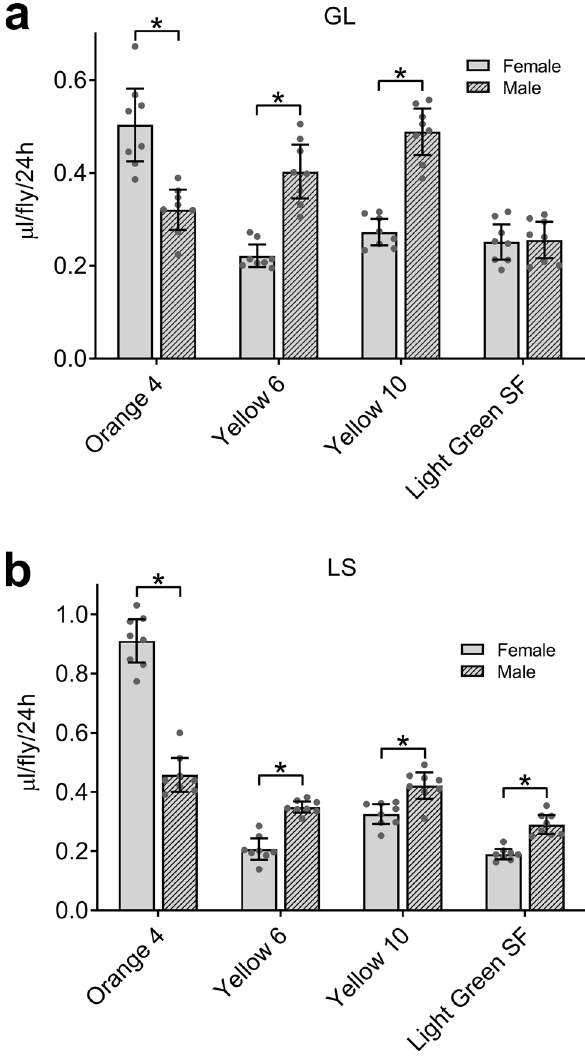
Figure 4. Four lead dyes in Con-Ex: effect of sex in two control strains. ExVial in GL ( a ) and LS ( b ) males and females measured after 24 h with the indicated dyes (1% w/v) in 2Y10S3C media. Sex and the dye used significantly affected ExVial (independent two-way ANOVAs; A: sex, p = 0.0003; dye, p < 0.0001; interaction, p < 0.0001; B: sex, p = 0.0300; dye, p < 0.0001; interaction, p < 0.0001; n = 8). ExVial was significantly affected by sex in both strains as measured by all four dyes (*Bonferroni’s, p = 0.0016 to < 0.0001) except for Light Green SF in GL flies (panel A, p >